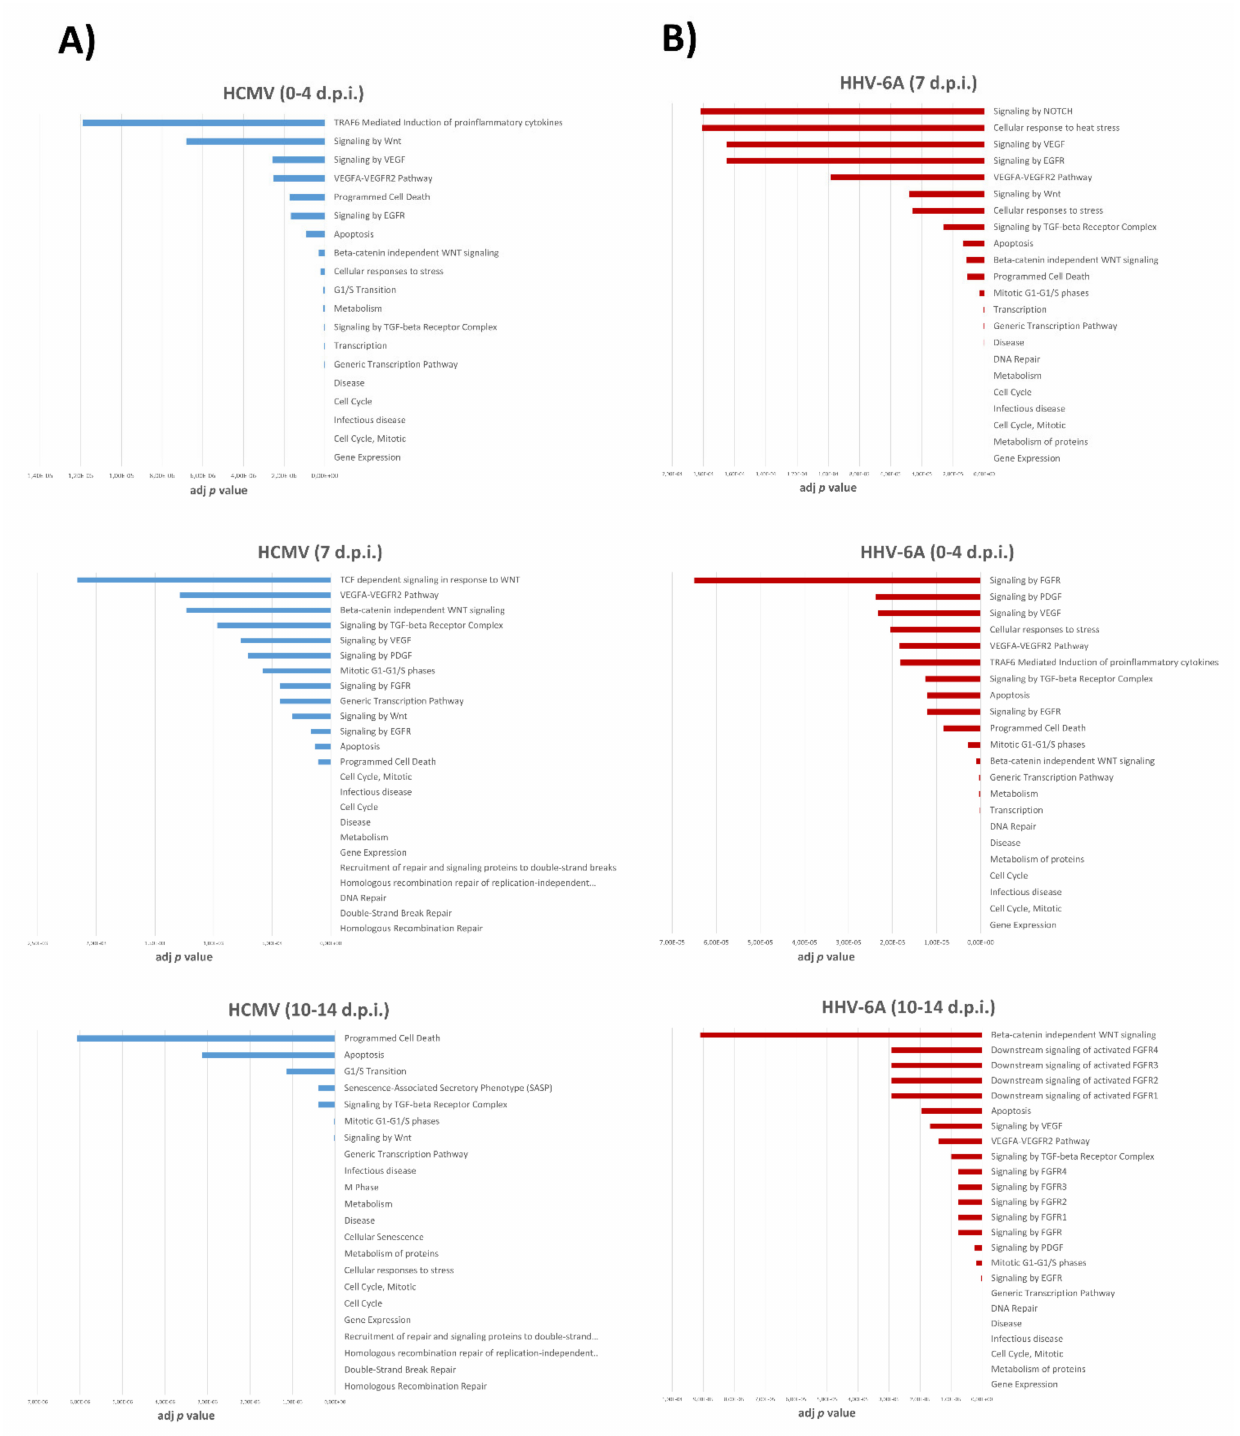
Figure 6. Network connectivity analysis based on differentially expressed miRNAs in HCMV ( A ) and HHV-6A ( B ) infected fibroblasts. Early (0–4 d.p.i.), intermediate (7 d.p.i.) and late (10–14 d.p.i.) effects are shown for both viruses. Results are expressed as adjusted p value, indicating how statistically significant is the correlation. A lower p value represents a higher